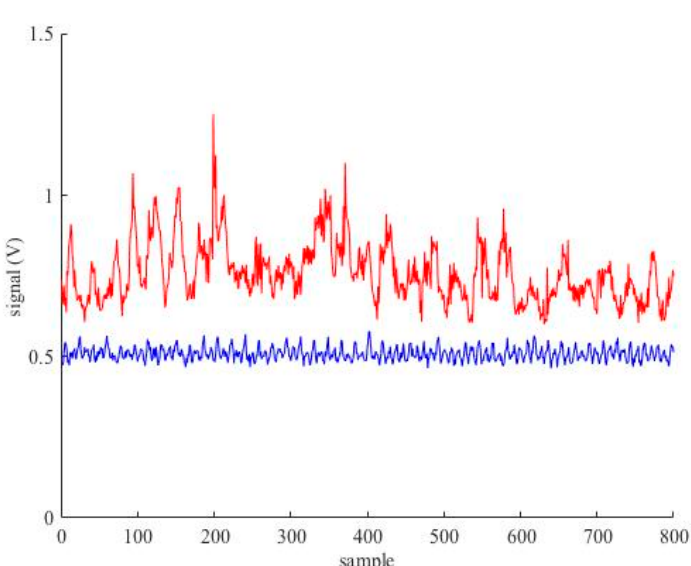
Figure 7. Irregular plastic particle–glycerin solution C. Load cell signal (sample rate 50 Hz) for representative runs corresponding to “simple shearing” (blue line) and “partially shearing” (red line) condition.